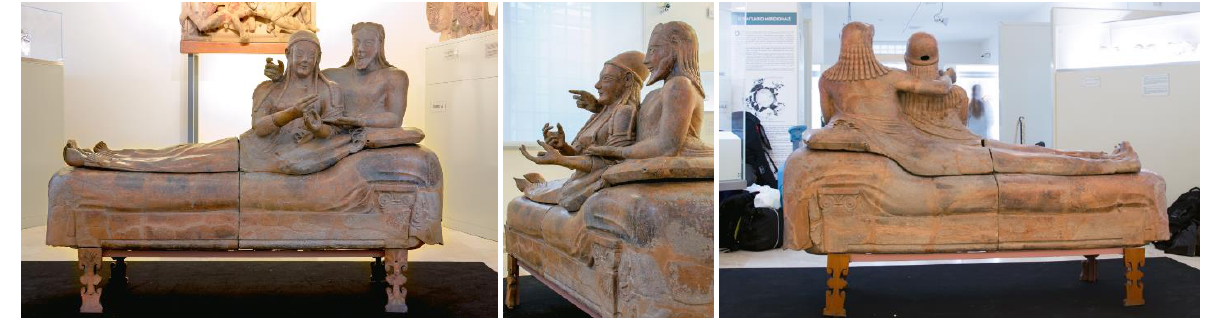
Figure 1. The Sarcophagus of the Spouses in its temporary location in Villa Giulia Museum,